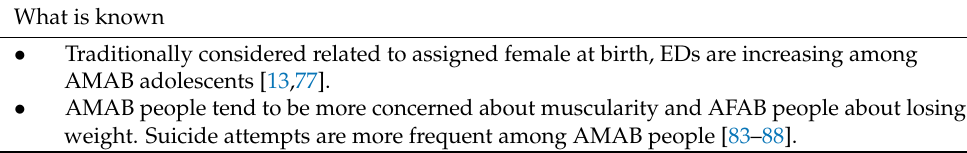
Table 5. Available evidence on the relationship between eating disorders (EDs) and